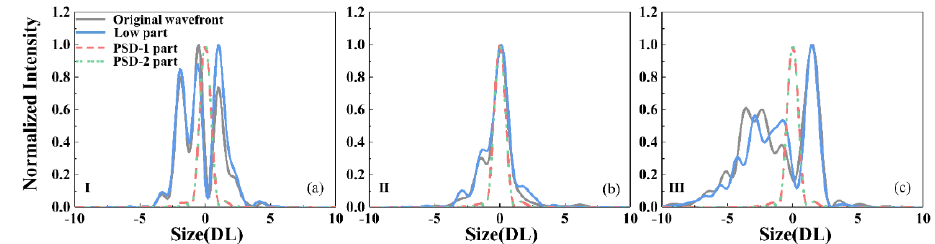
Figure 5. Normalized intensity of focal spot different wavefront types with PV = 2 λ . ( a ) is the focal intensity of the original, the low spatial frequency, the PSD-1, and the PSD-2 of type I, when the PV value of them all is 2 λ , respectively; ( b , c ) are the focal intensity of type II and type III, respectively, same as ( a ).